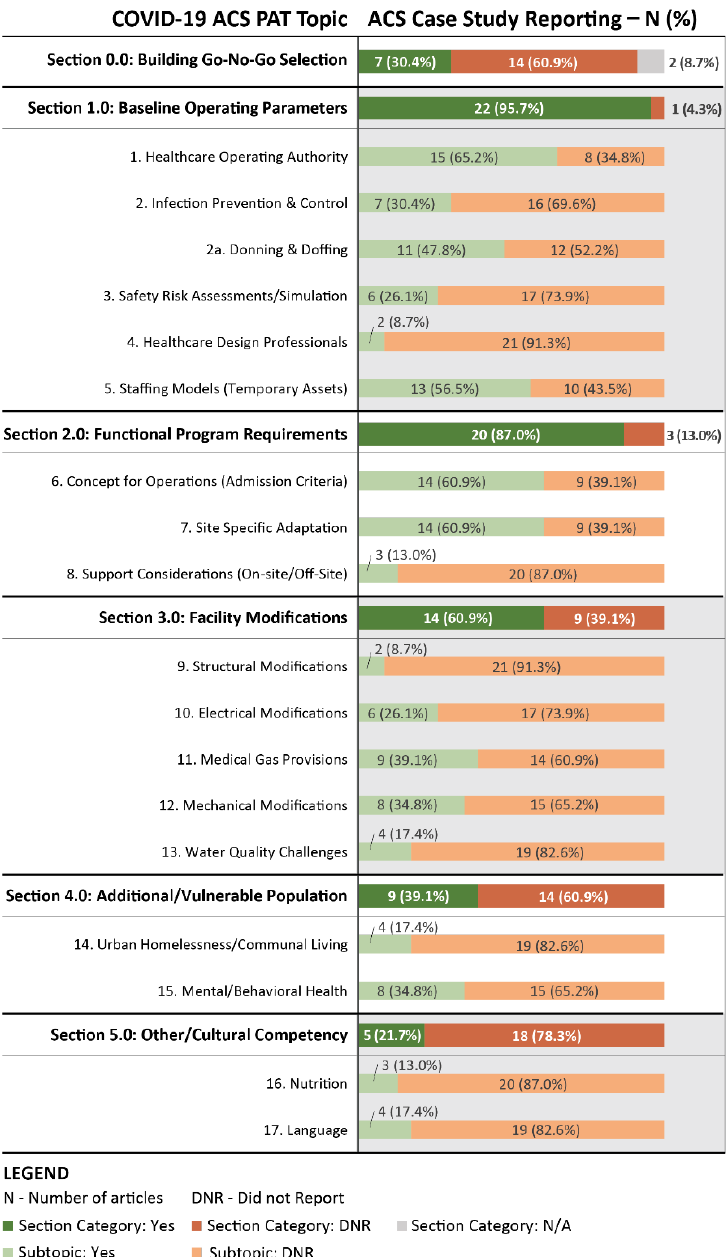
Figure 5. Summary statistics of alignment between COVID-19 ASC PAT and ACS case studies .